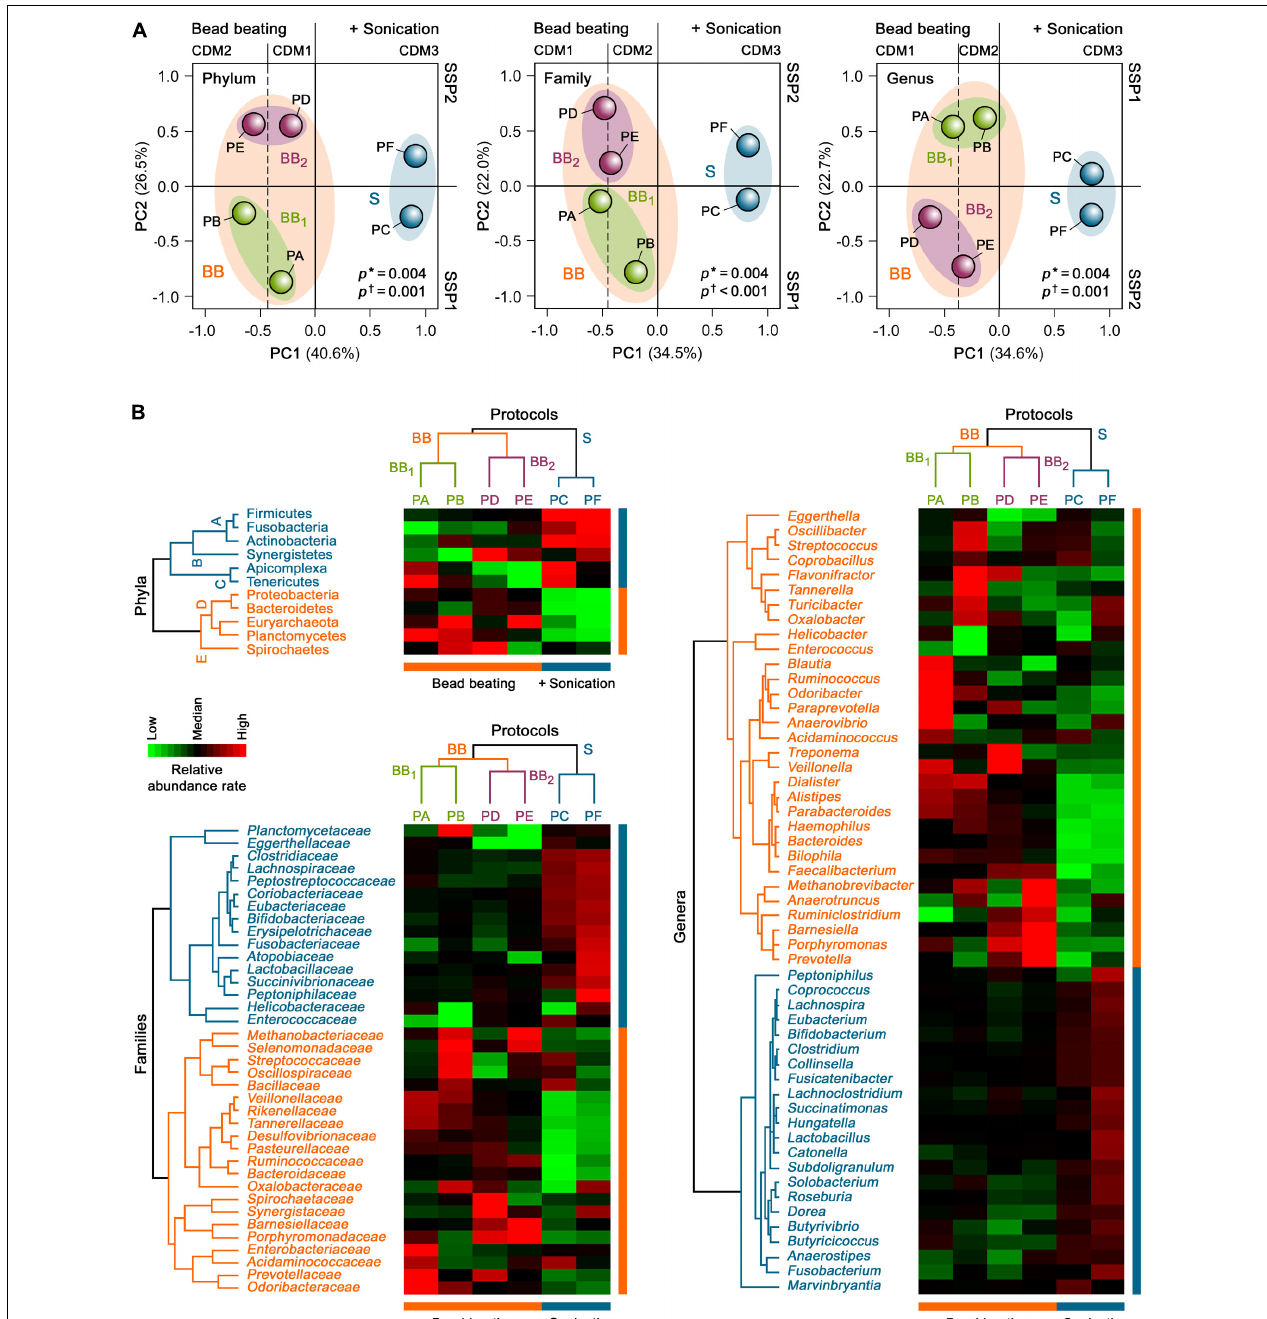
FIGURE 4 | Unsupervised (A) PCA and (B) HCA of the taxonomic profiles of the gut metaproteome of H1 isolated with different microbial protein extraction protocols. Asterisks show the degree of homology of taxonomic abundance profiles of human gut microbiota of H1 between the study groups, whereas daggers indicate their degree of homogeneity within each study